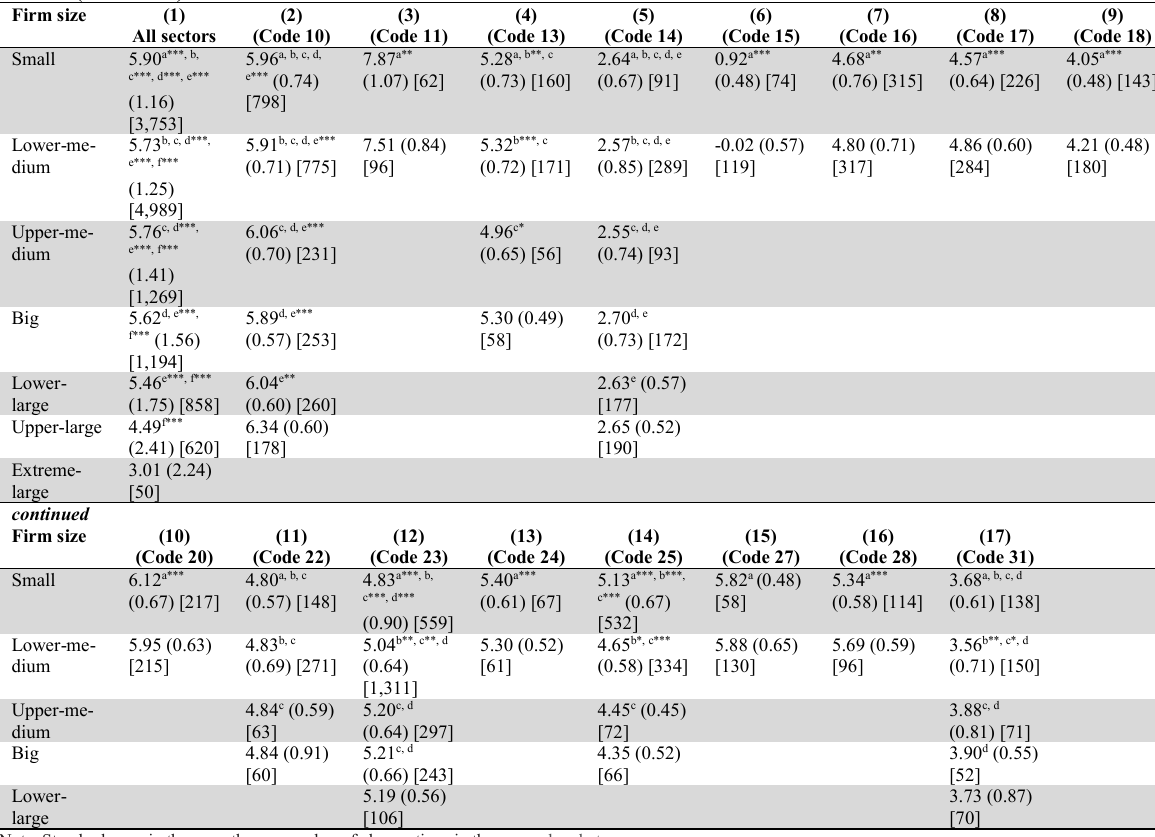
Labor heterogeneity in TFP distance (compared to top 3): Vietnamese manufacturing domestic private sector (2010-16) Firm size